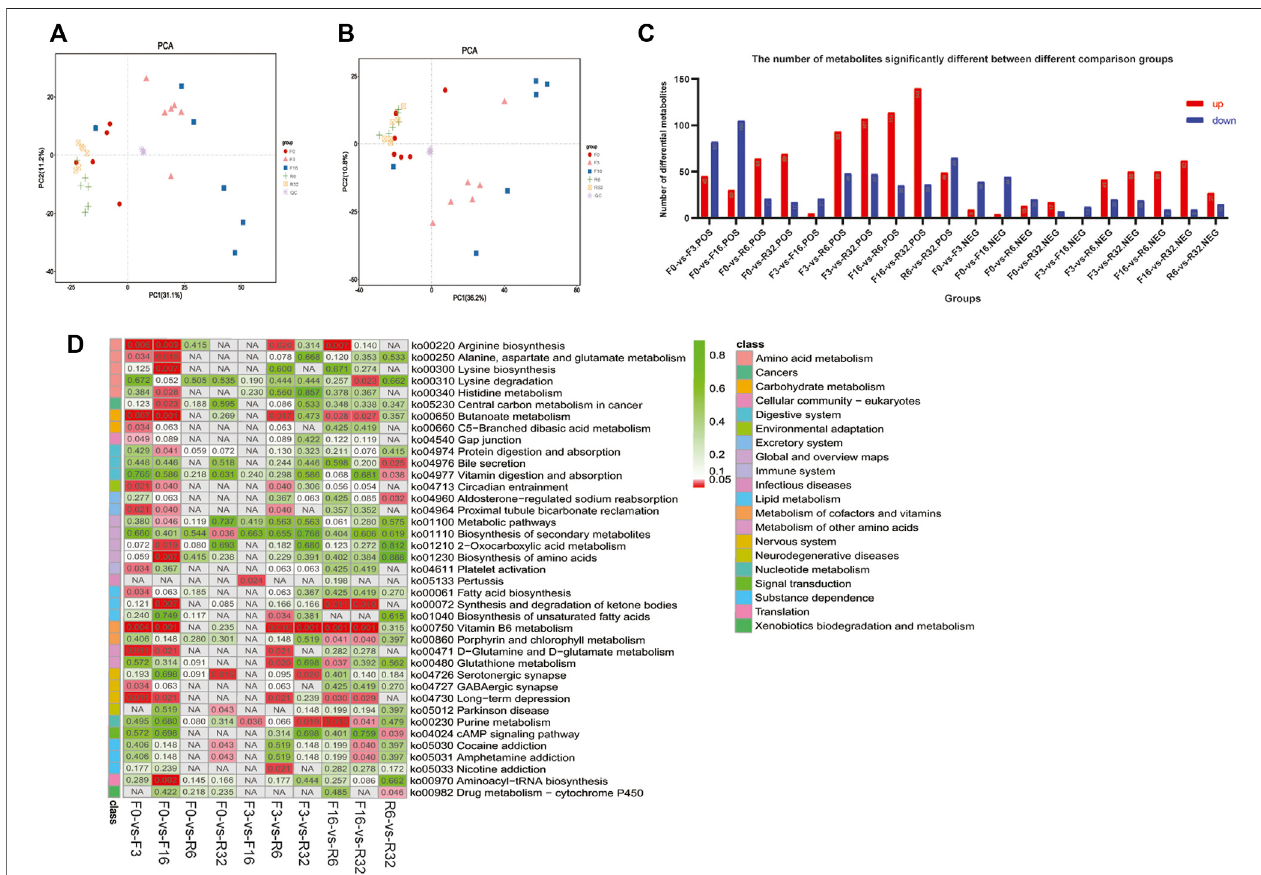
FIGURE 6 | Metabolome analysis. Principal component analysis (PCA) was performed on all samples and quality control samples in (A) positive ion mode and (B) negative ion mode. (C) Number of differential metabolites between the comparison groups in positive and negative ion modes. (D) KEGG enrichment analysis of differential